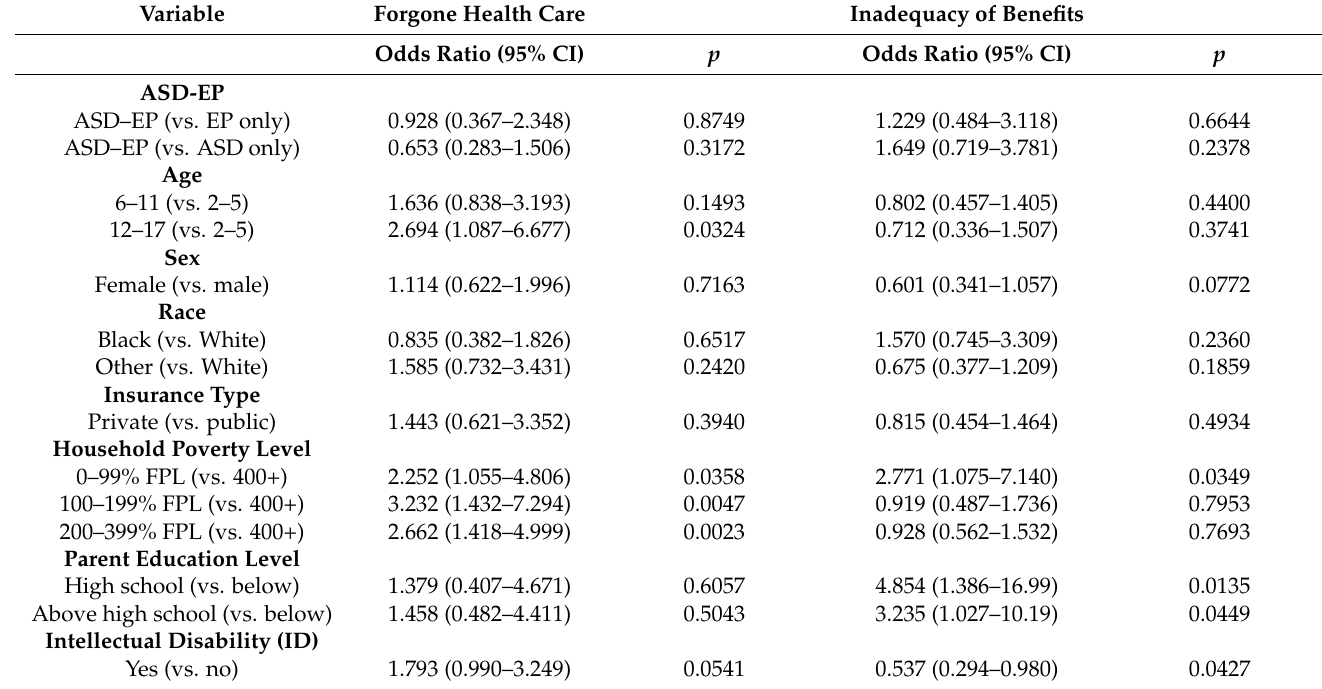
Table 5. Adjusted odds ratios for forgone care and inadequacy of